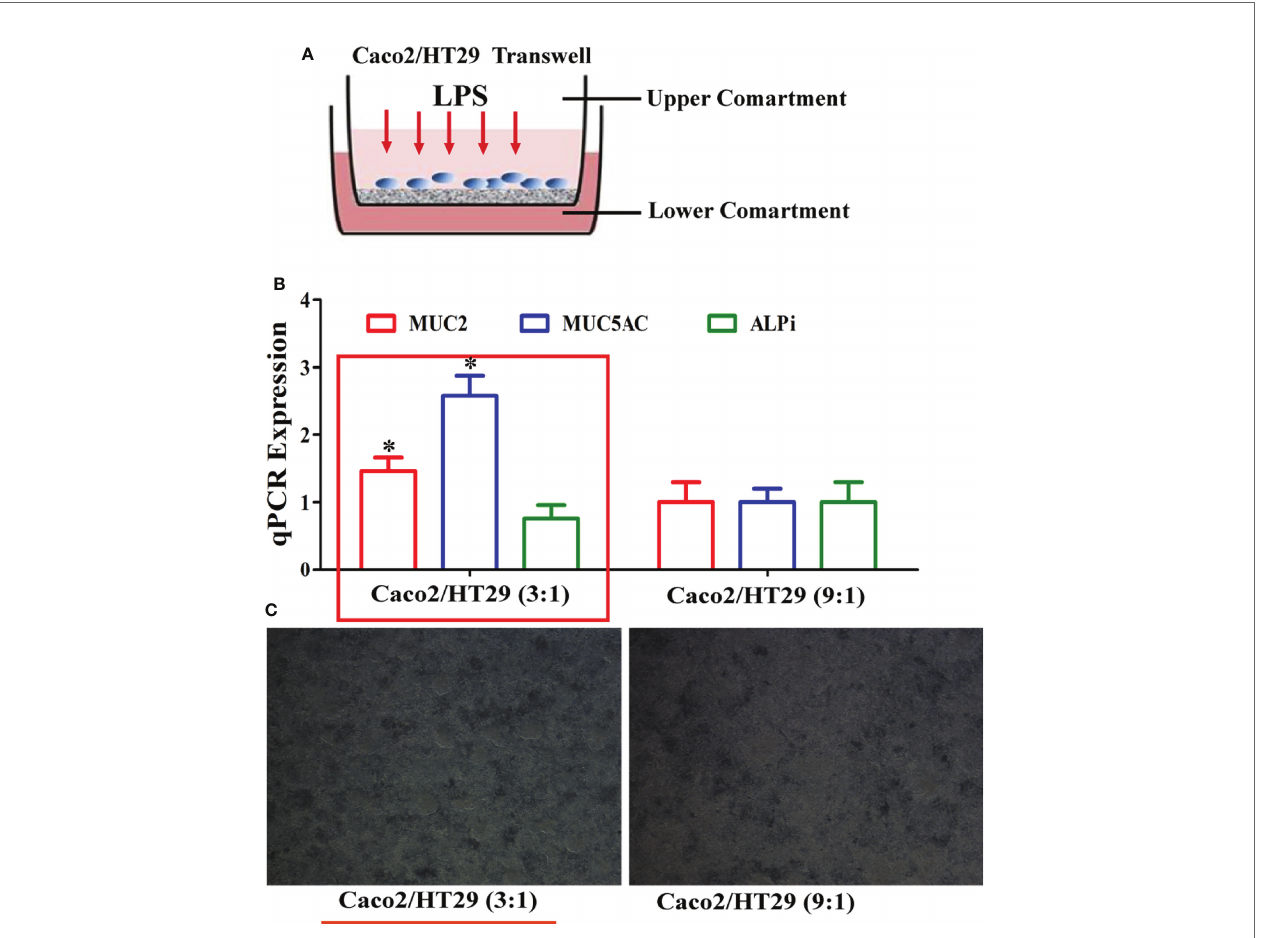
FIGURE 1 | Establishment of the Caco2/HT-29 cell co-culture model. (A) , Transwell of the Caco-2/HT-29 co-culture cell model; (B) , MUC2, MUC5AC, and ALPi mRNA expression of the Caco-2/HT-29 co-culture cell at two cell seeding ratios (N=6); (C) , Image of the Caco-2/HT-29 co-culture cell at two cell seeding ratios (×200).* Statistical difference between co-culture Caco2/HT-29 cells (3:1) compare to co-culture Caco2/HT-29 cells (9:1) for the same factor ( P